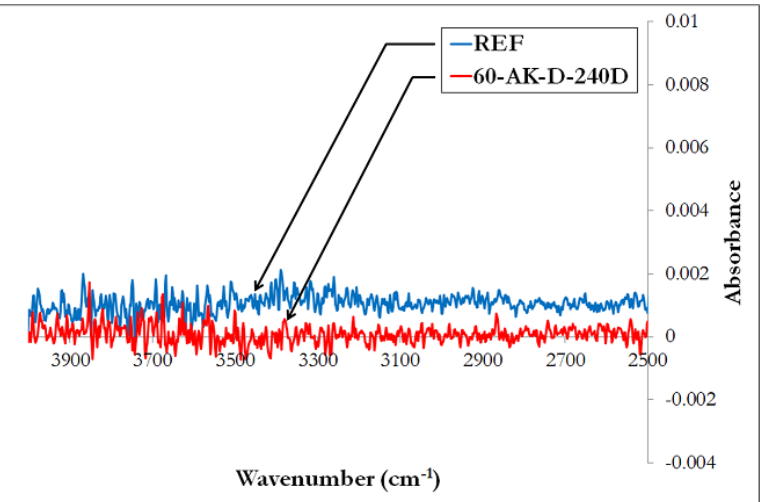
Figure 11. FTIR spectra in the region of 2500–4000 cm − 1 from a reference sample (REF) and from a sample aged in the alkaline solution at 60 ◦ C for 240 days